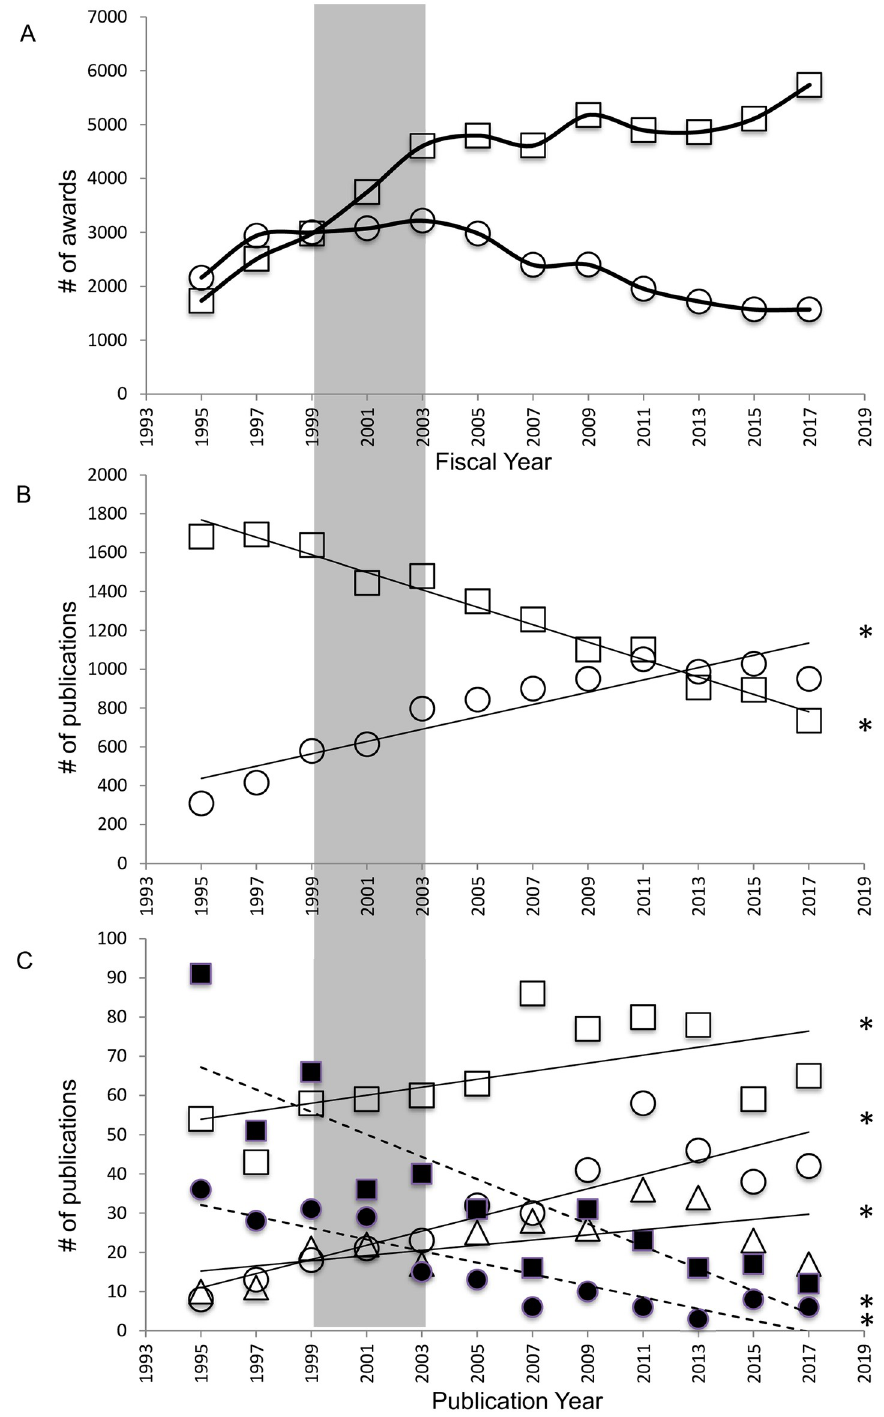
Fig 5. NIH grant funding and publications for GMOs and MOs on the 1999 canonical model species list. A. NIH neuroscience awards for canonical animal model organisms with (squares; GMOs) and without (circles; MOs) molecular genetic tools. B. Title search for publications using the canonical rodent model species rat (squares; MO) and mouse (circles; GMO). C. Title search for publications using canonical GMOs ( Drosophila (open squares), zebrafish (open circles), C . elegans (open triangles)) and canonical MOs (chick (closed squares), Xenopus (closed circles)). Shaded area indicates time period between release of the NIH canonical model species list and the NIH Roadmap. Asterisks indicate significant increase in publications using Drosophila , zebrafish, and C . elegans , and significant decrease in publications using chick and Xenopus